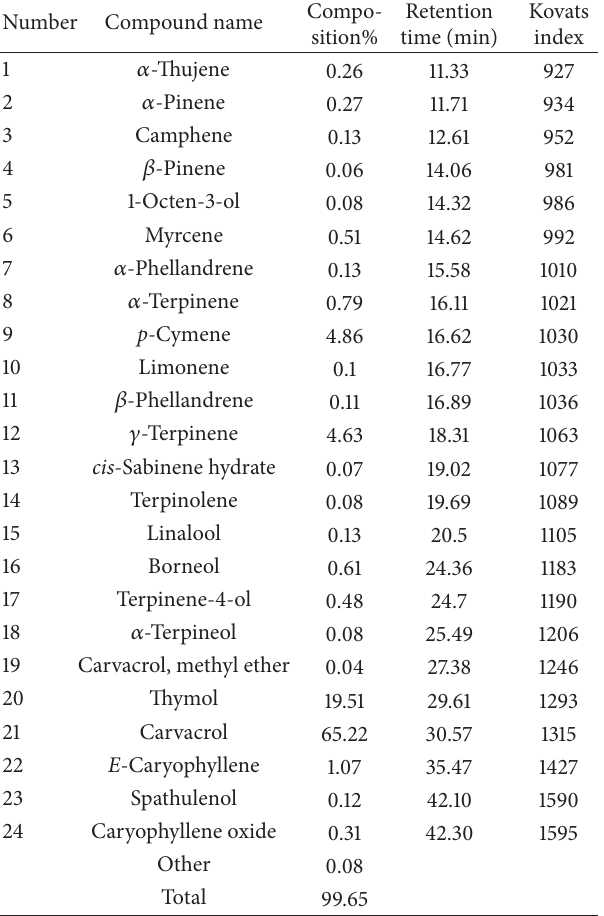
Table 1: Essential oil composition of Z . clinopodioides identified by